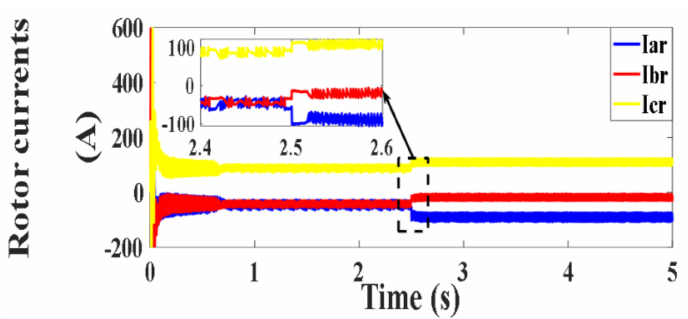
Figure 64. Rotor currents under PVC (A).